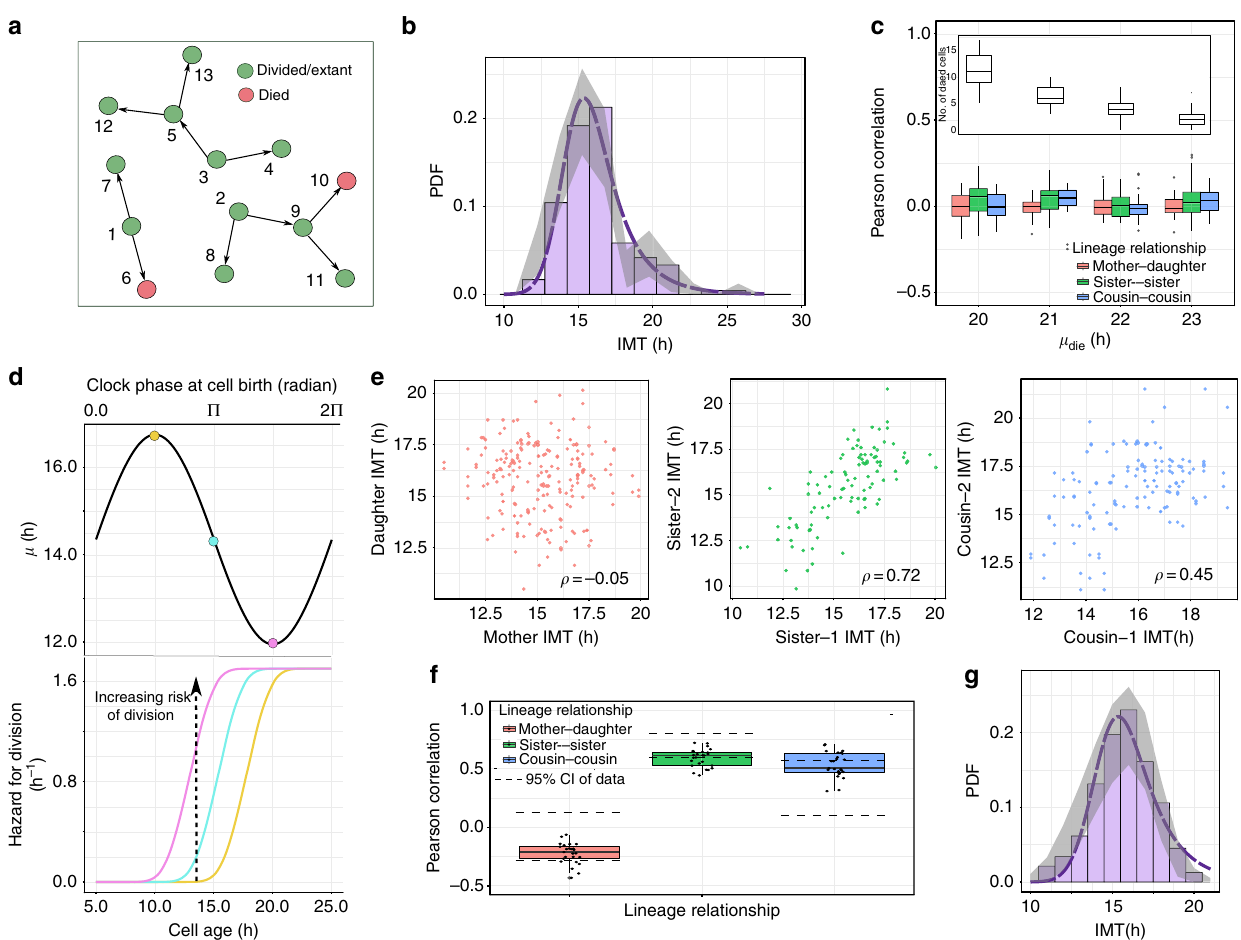
Fig. 5 Coupling of the cell cycle to the circadian rhythm is required to explain correlations in the absence of cisplatin. a Birth-death process simulations keeping track of lineage relationships. Three ancestor cells and their progeny are shown here as examples. Directed edges represent mother – daughter relationships. b , c Results of a null model with no circadian gating. b The IMT distribution before cisplatin (purple dashed line, EMG parameters in Supplementary Table 4) is almost identical to the experimental data (histogram, EMG parameters in Supplementary section 4). The gray shaded area represents 95% con fi dence intervals generated from 1000 bootstrap samples of the data. c Pearson correlations between cell pairs as μ die of the EMG function is varied. The inset shows the number of dead cells in 25 simulation runs, for different values of μ die . d – g Model incorporating circadian gating of the cell cycle and results. d A model for the coupling of the circadian clock to the cell cycle. As the phase of the clock at cell birth varies between 0 and 2 π , the parameter μ of the EMG function for division varies, thereby controlling the hazard for cell division (top). Three hazard functions corresponding to three phases of the clock are shown in matched colors (bottom), modeling different division risks for three cells born at different phases of the clock. e Instances of Pearson correlations in IMT ( ρ ) generated from the model with circadian gating of the cell cycle. f The cousin – mother inequality and the magnitude of all lineage correlations are recapitulated with the model for circadian gating of the cell cycle. The dashed lines indicate the 95% con fi dence intervals of the IMT correlations as measured from the data. g The histogram represents one example of the IMT distribution generated by our simulations incorporating circadian gating. Gray shaded area represents 95% con fi dence intervals generated from 500 simulation runs. The dashed line represents the inferred IMT distribution, as in b . All parameters used for simulated results in e – g are provided in Supplementary section 6. All boxplots represent the 1st, 2nd, and